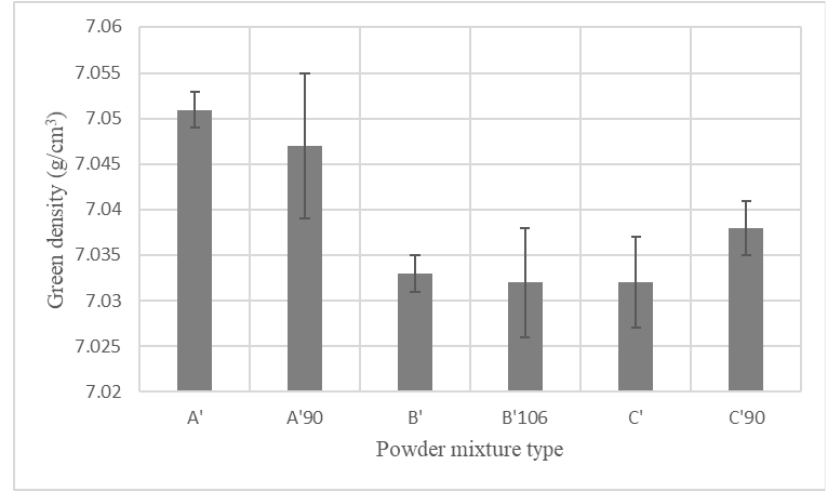
Figure 9. Compressibility evaluation for PMS mixtures (including 0.7 wt. % of the lubricant).